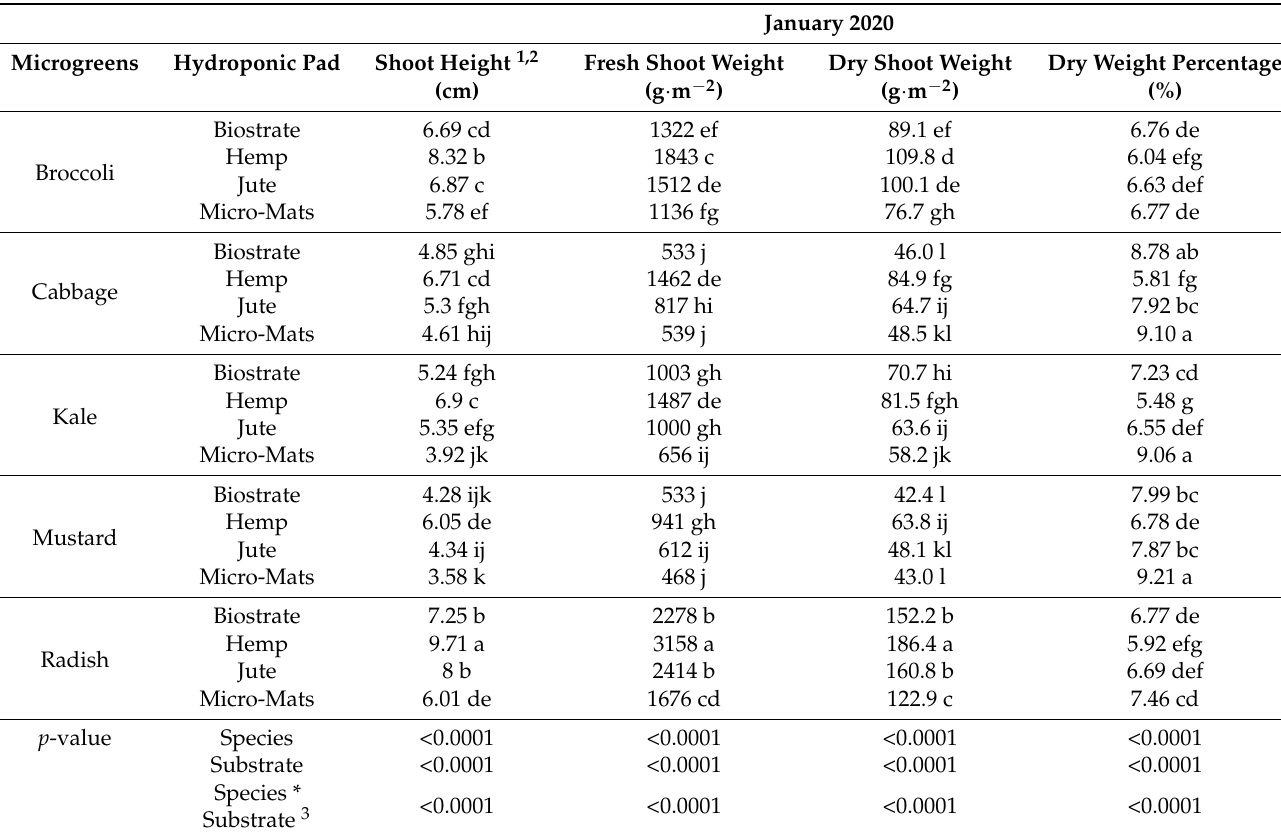
Table 3. Shoot height, fresh shoot weight, dry shoot weight, and dry weight percentage of five microgreens affected by the interaction between species and hydroponic pad type in January 2020.